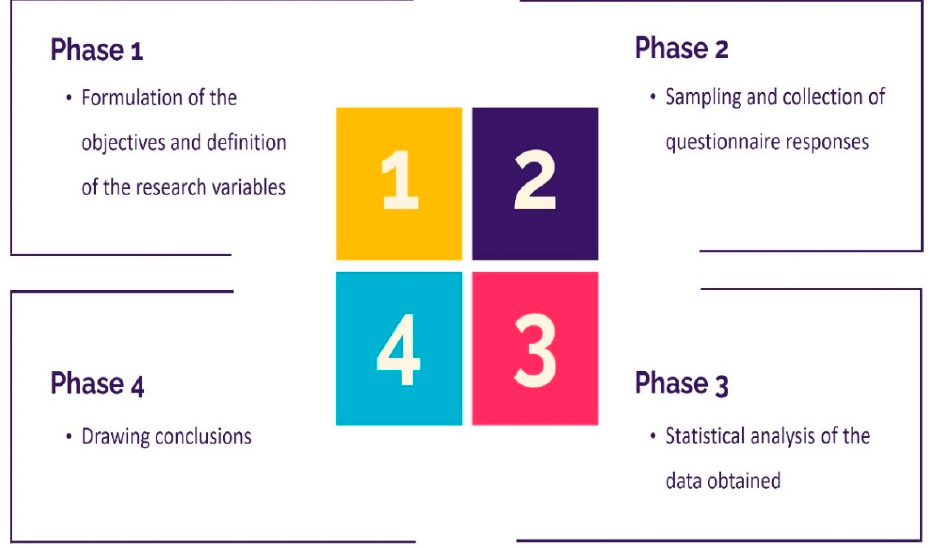
Figure 6. Research phases.